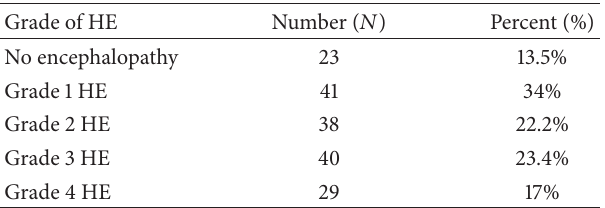
Table 5: Distribution of patients into different grades of hepatic encephalopathy (HE) as per West-Haven criteria.